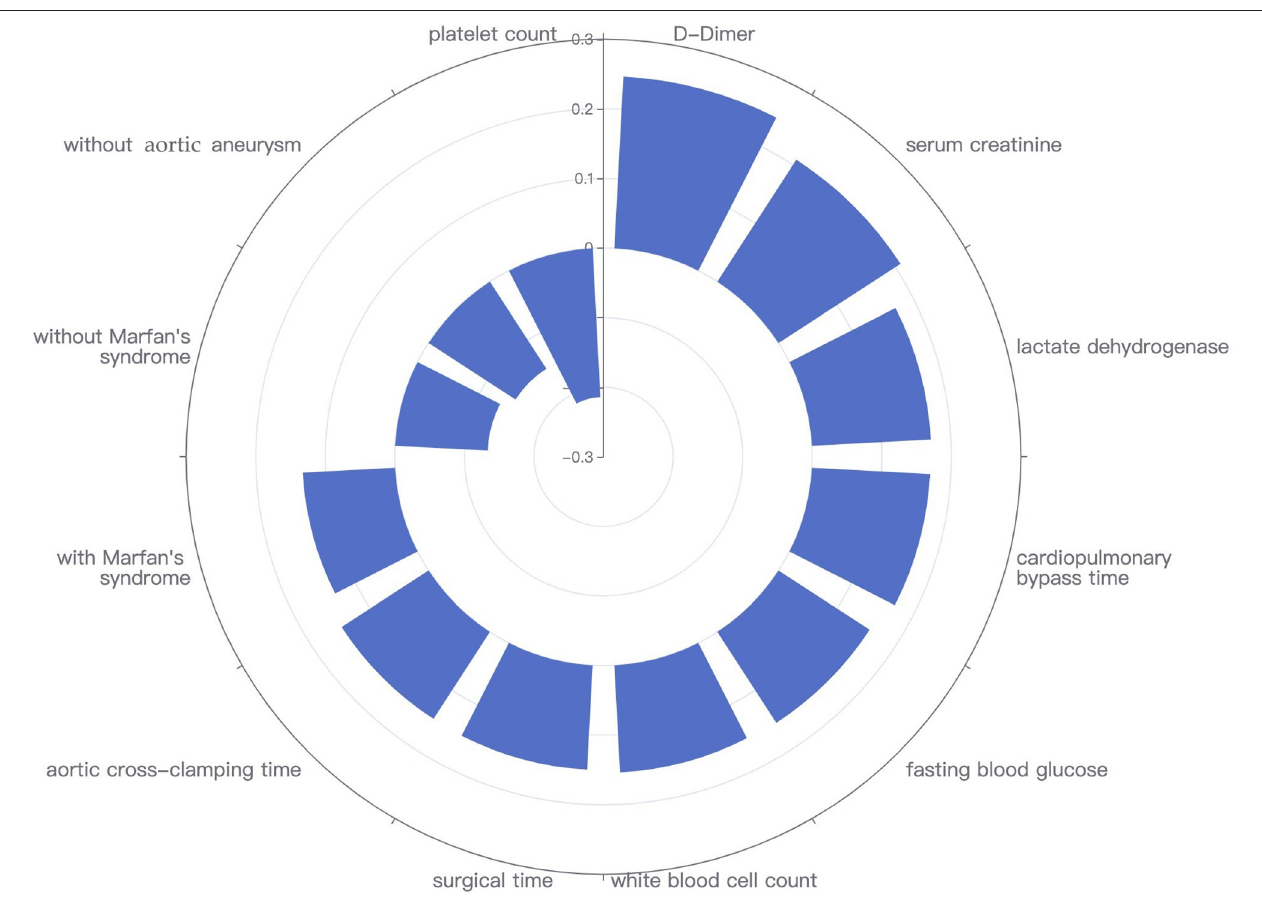
FIGURE 1 | Twelve features selected by Kendall correlation coefficient for models building.